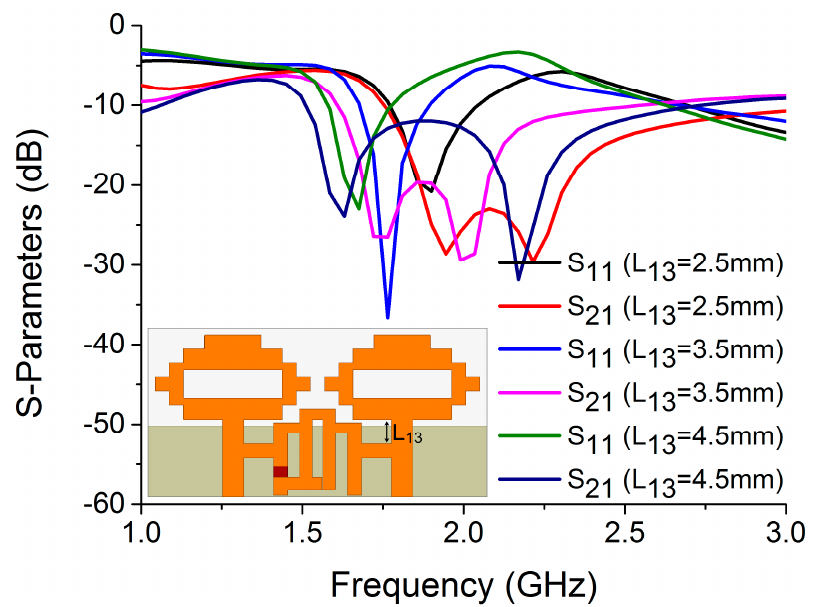
Figure 23. Influence of L 13 on S-parameters.